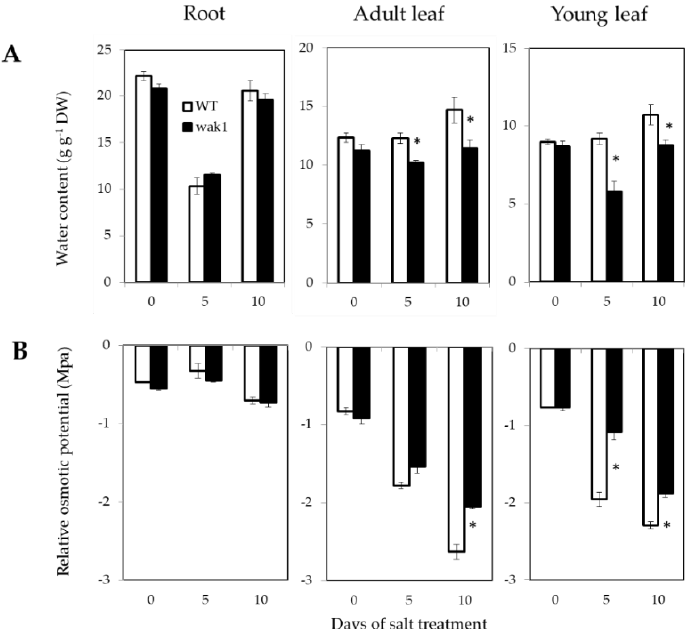
Figure 4. The Slwak1 mutant is affected in osmotic homeostasis under salt stress. ( A ) Water contents and ( B ) osmotic potentials, relative to water content of hydrated cell, were analyzed in roots, adult and young leaves of WT and Slwak1 plants after 0, 5 and 10 days of salt treatment (200 mM NaCl). Data are expressed as mean ± SE ( n = 5). Asterisks indicate significant differences between mean values of WT and Slwak1 at the same organ and culture condition (Student ’ s t -test, p < 0.05).